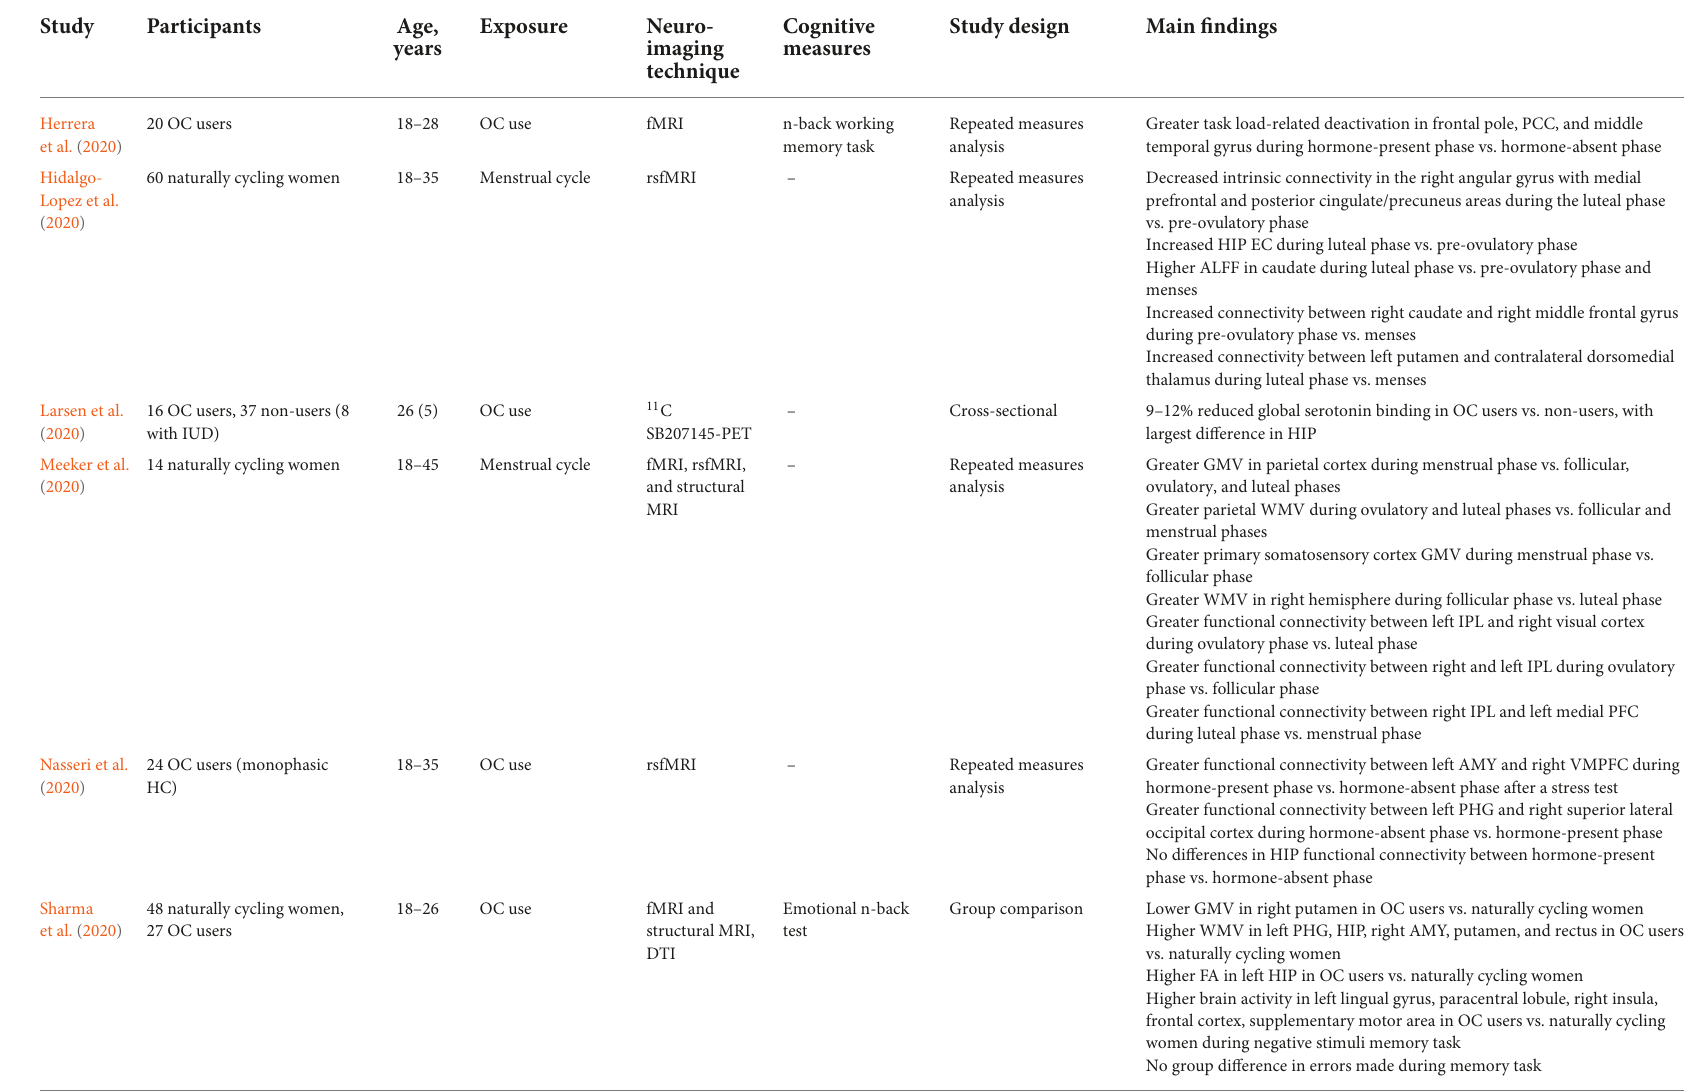
Decreased intrinsic connectivity in the right angular gyrus with medial prefrontal and posterior cingulate/precuneus areas during the luteal phase vs. pre-ovulatory phase Increased HIP EC during luteal phase vs. pre-ovulatory phase Higher ALFF in caudate during luteal phase vs. pre-ovulatory phase and menses Increased connectivity between right caudate and right middle frontal gyrus during pre-ovulatory phase vs. menses